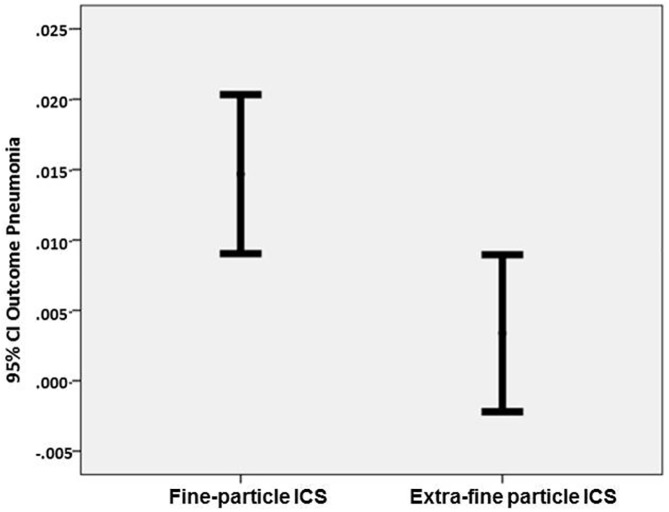
Probability (95% CI) of pneumonia in outcome period by treatment group.